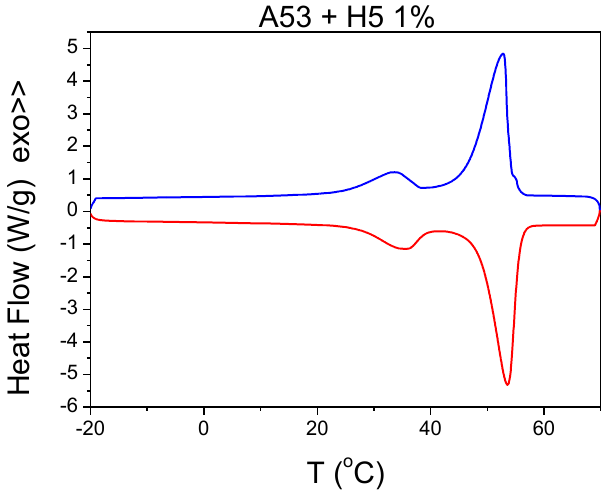
Figure 1. Typical DSC curve (A53 + H5 0.01 mass fraction).